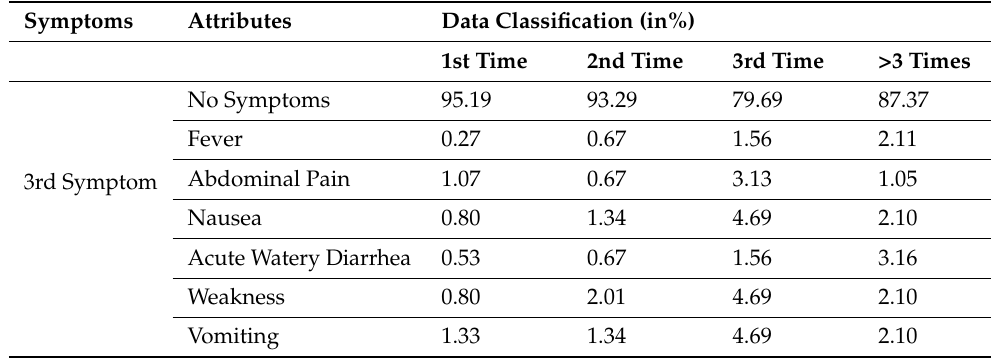
Table 11. Data classification statistics including outliers’ data on disease